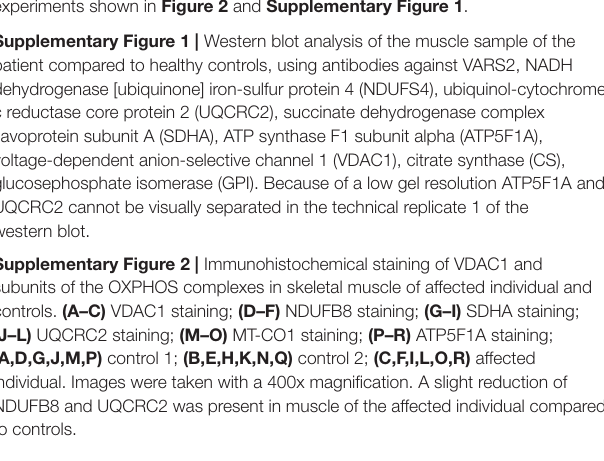
Supplementary Table 1 | Densitometric analysis of the western blotting experiments shown in Figure 2 and Supplementary Figure 1 . Supplementary Figure 1 | Western blot analysis of the muscle sample of the patient compared to healthy controls, using antibodies against VARS2, NADH